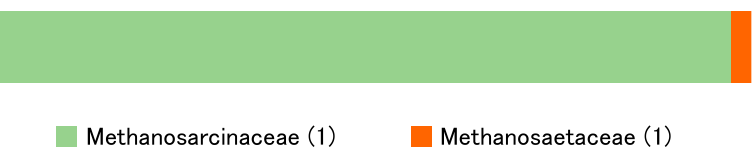
Figure 3. Community structure of archaeal clones at the family level. The number in parenthesis is the number of OTUs belonging to each family. Both families are affiliated with the phylum Euryarchaeota. Table 2. List of archaeal clones.